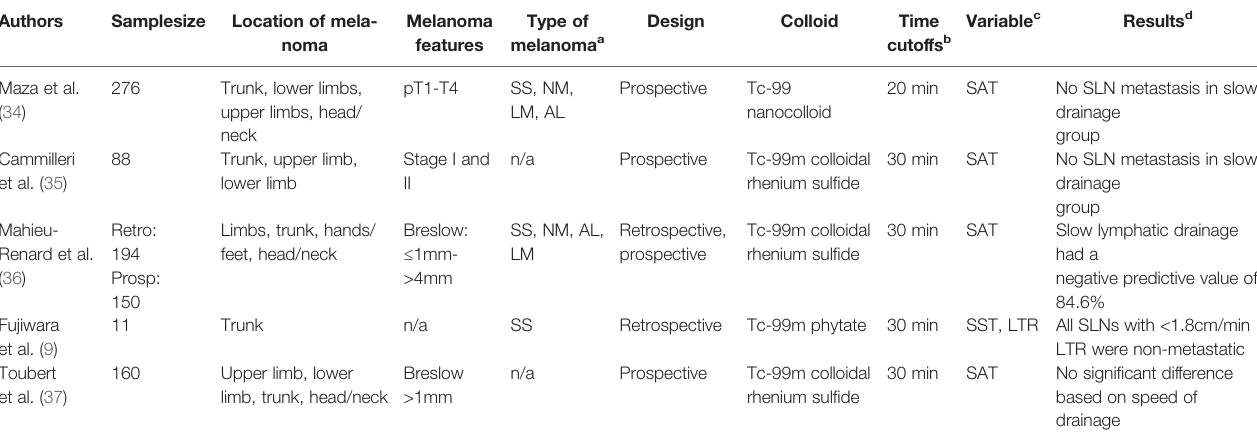
TABLE 4 | Studies evaluating lymphatic transport kinetics as predictive of sentinel lymph node metastasis.